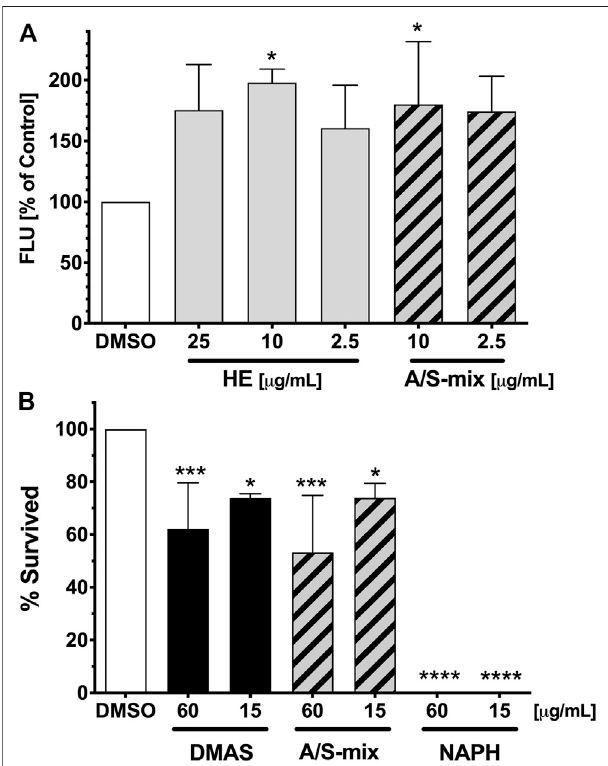
FIGURE 8 | Fat Accumulation and survival of C. elegans upon treatment with Alkanna tinctoria (L.) Tausch samples. (A) Differences in vital Nile red fl uorescence (FLU) of C. elegans treated with vehicle control (DMSO 1%), and different concentrations of HE and A/S-mix. Bars represent the mean fl uorescence of three independent experiments with six well replicates expressed as % of control worms ±SD. The presented values were obtained by measuring the fl uorescence of 44 – 71 worms per sample. Signi fi cance was assessed by One-Way ANOVA and Dunnett ’ s post-test (*, p < 0.05). (B) Survival rates (%) after 10 days of treatment with the vehicle control (DMSO 1%) and the samples DMAS, A/S-mix and NAPH. All sample were tested at a concentration of 60 and 15 μ g/ml. Bars represent the mean survival rate of three independent experiments ±SD. The presented values were obtained by assaying a total of 67 – 93 worms per sample. Signi fi cance was assessed by One-Way ANOVA and Dunnett ’ s post-test (*, p < 0.05; ***, p < 0.001; ****, p <